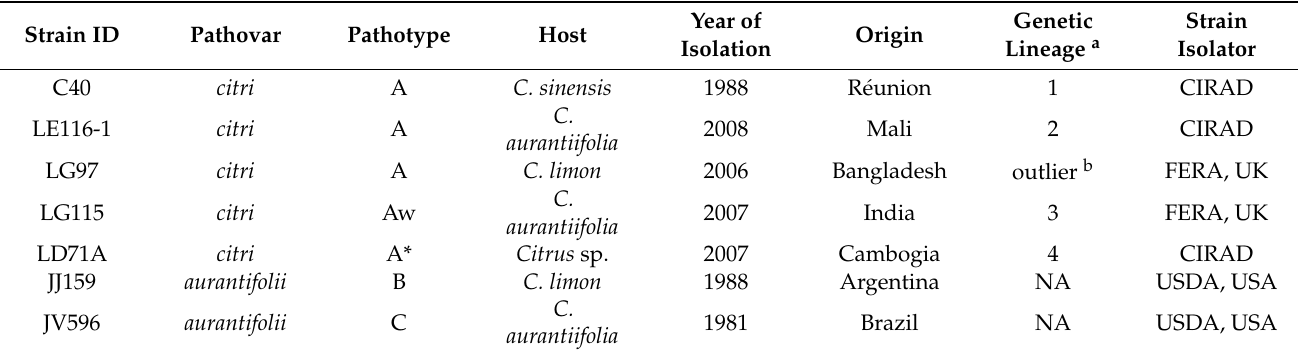
Table 1. Xanthomonas citri pv . citri and pv. aurantifolii used in this